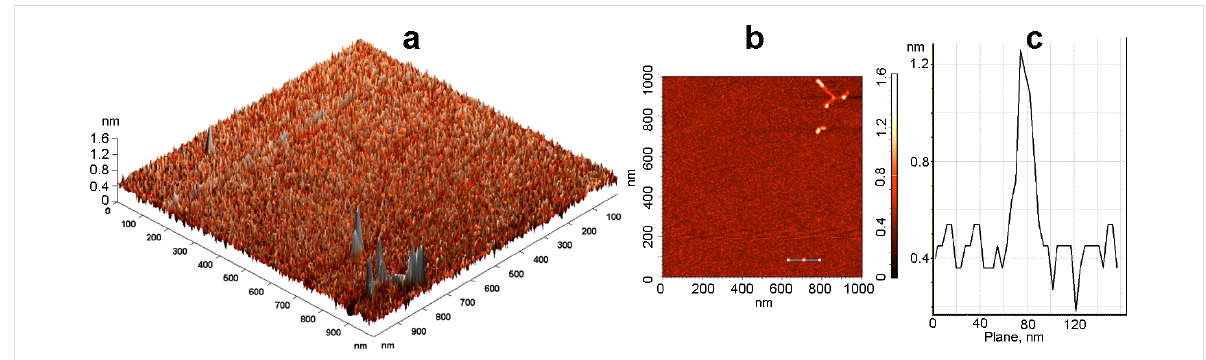
Figure 4: (a) 3D and (b) 2D AFM images of the Si–NH 2 ·ODN(1) nanocomplex and (c) a suface profile along the line specified in